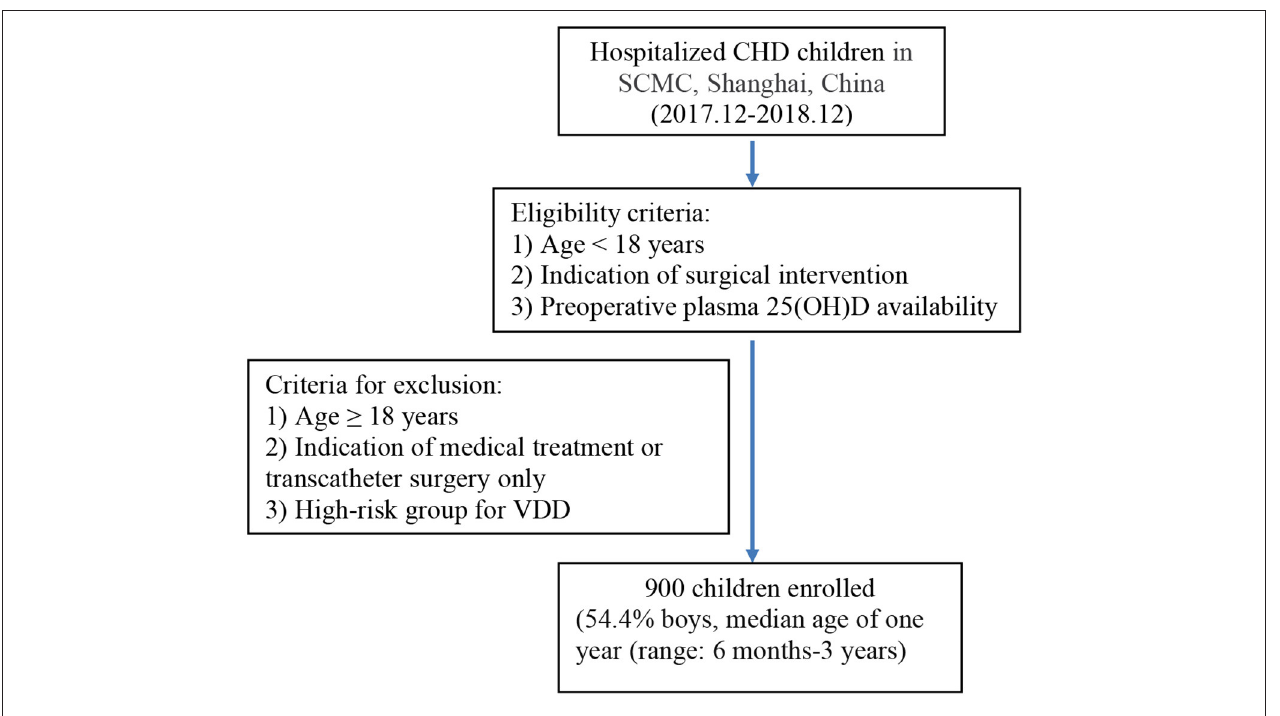
FIGURE 1 | Flowchart of the study